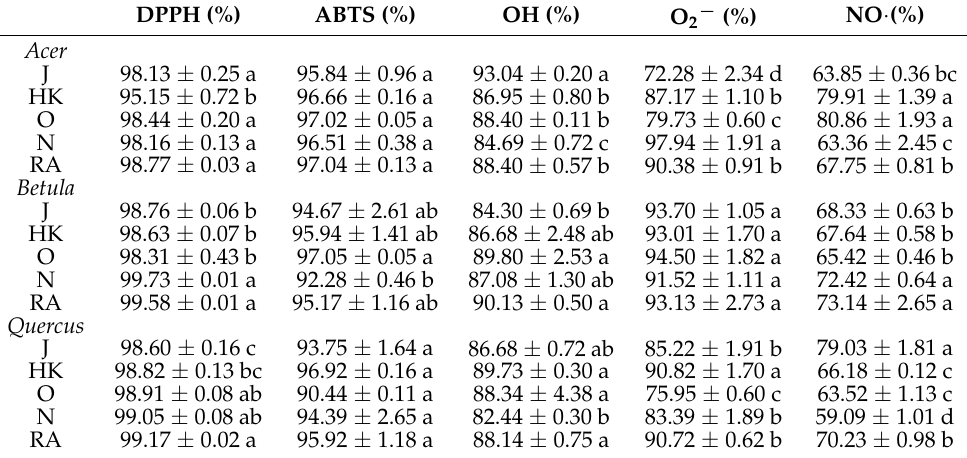
Table 5. Antioxidant activities of bud extracts. Values are expressed as mean ± SDs ( n = 5). J, Jiˇc í n; HK, Hradec Kr á lov é ; O, Opatovice n. Labem; N, Nadˇeje; RA, Rabštejnsk á Apatyka. Different letters show significant differences ( p < 0.05) between groups for the same